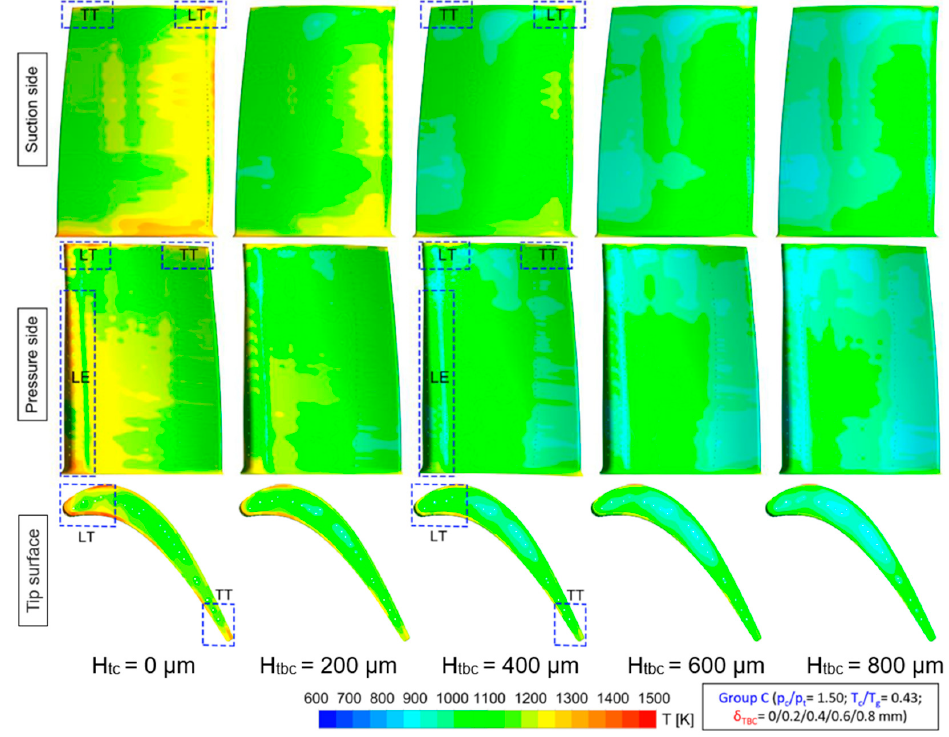
Figure 9. Comparison of temperature on the blade surface and the tip surface [55]. (H tc is thickness of the topcoat, LE, LT, and TT are leading edge, leading tip, and trailing tip, respectively).